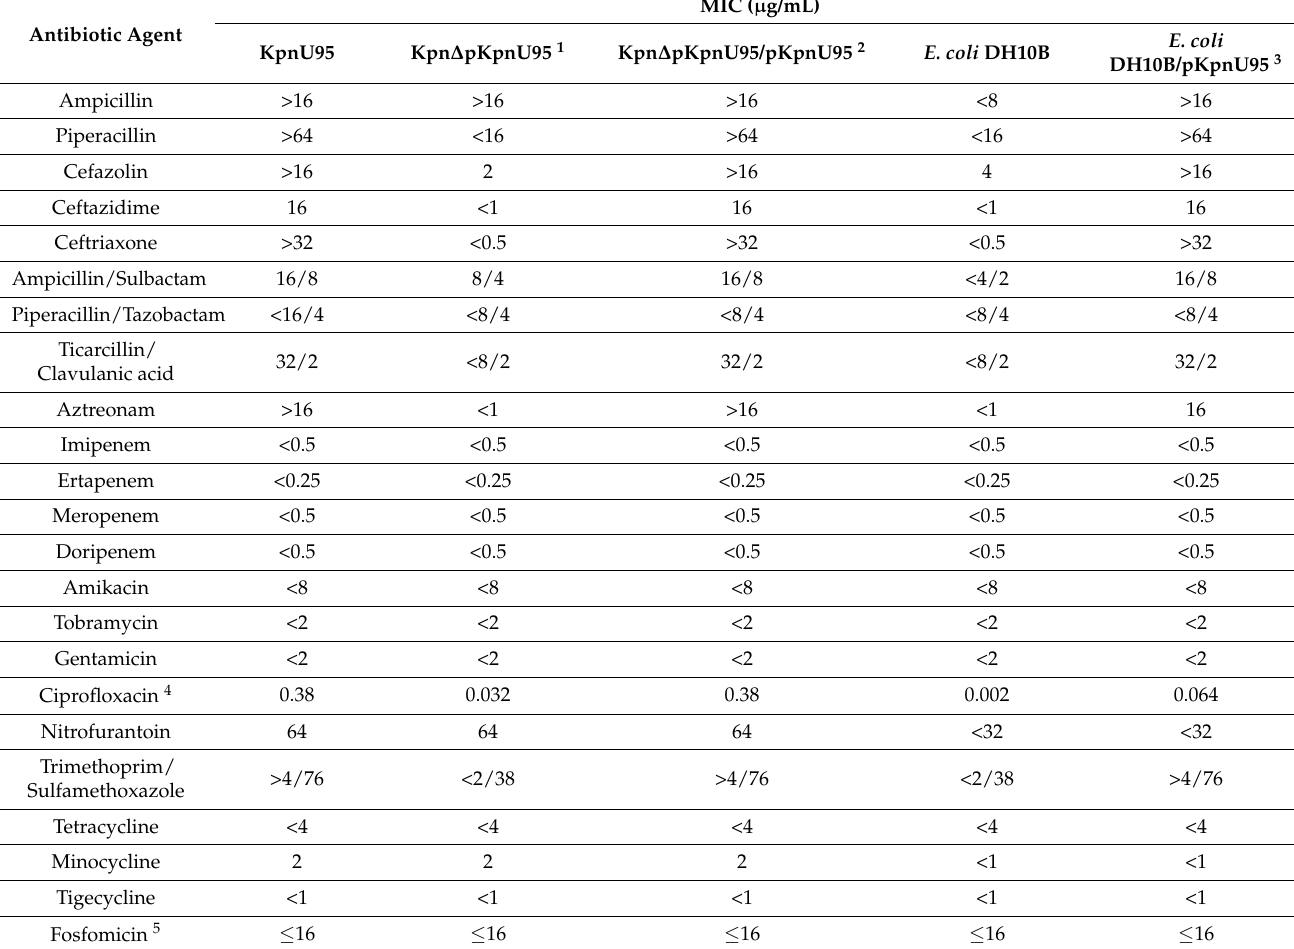
Table 1. Antibiotic susceptibilities of all the study